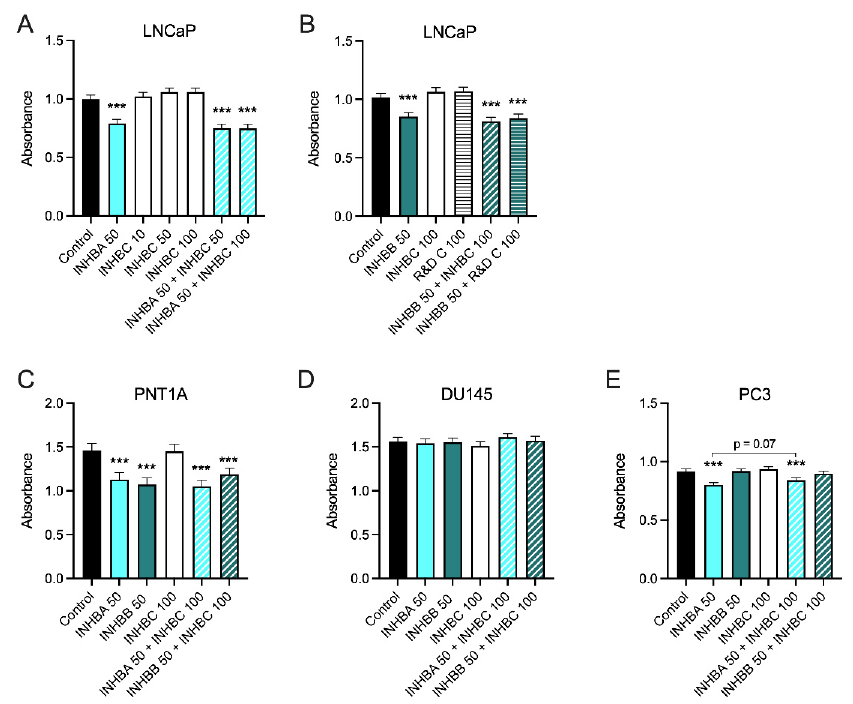
Figure 4. ( A – E ) MTS cell growth assays for prostate cell lines treated with exogenous recombinant INHBA, INHBB, INHBC, or INHBA or INHBB combined with INHBC (ng/mL). Data are presented as the emmean absorbance ± 95% confidence limits from a minimum of three separate biological replicates with three to six technical replicates per treatment per assay. Asterisks indicate significant differences between treated and untreated (control) cells *** p < 0.001 analysed by a NLM.